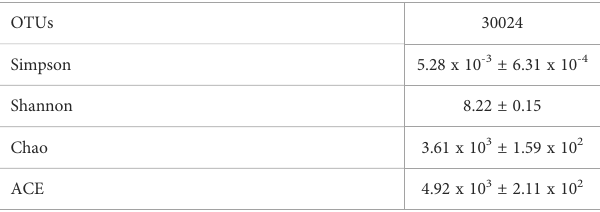
TABLE 2 Diversity indices observed in the rhizosphere metagenome of L. camara L. Each value is the mean of three replicates. OTUs